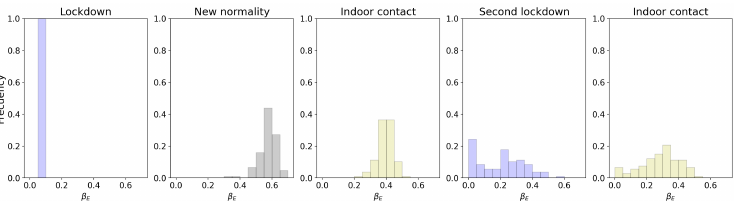
Figure 23. Histogram of the 107 different regions of Italy. The value of β E at the different levels of lockdown registered in